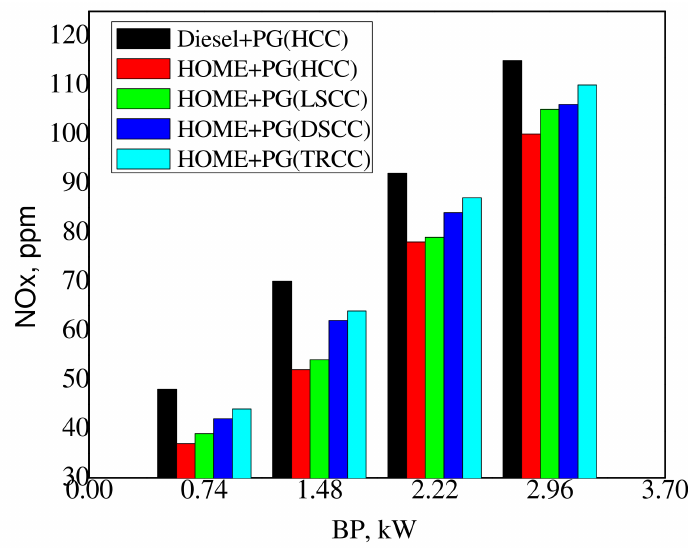
Figure 9. Effect of the combustion chamber type on NO X